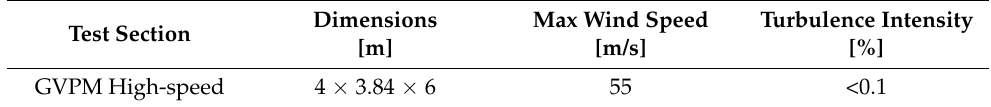
Table 1. Wind tunnel test section characteristics.